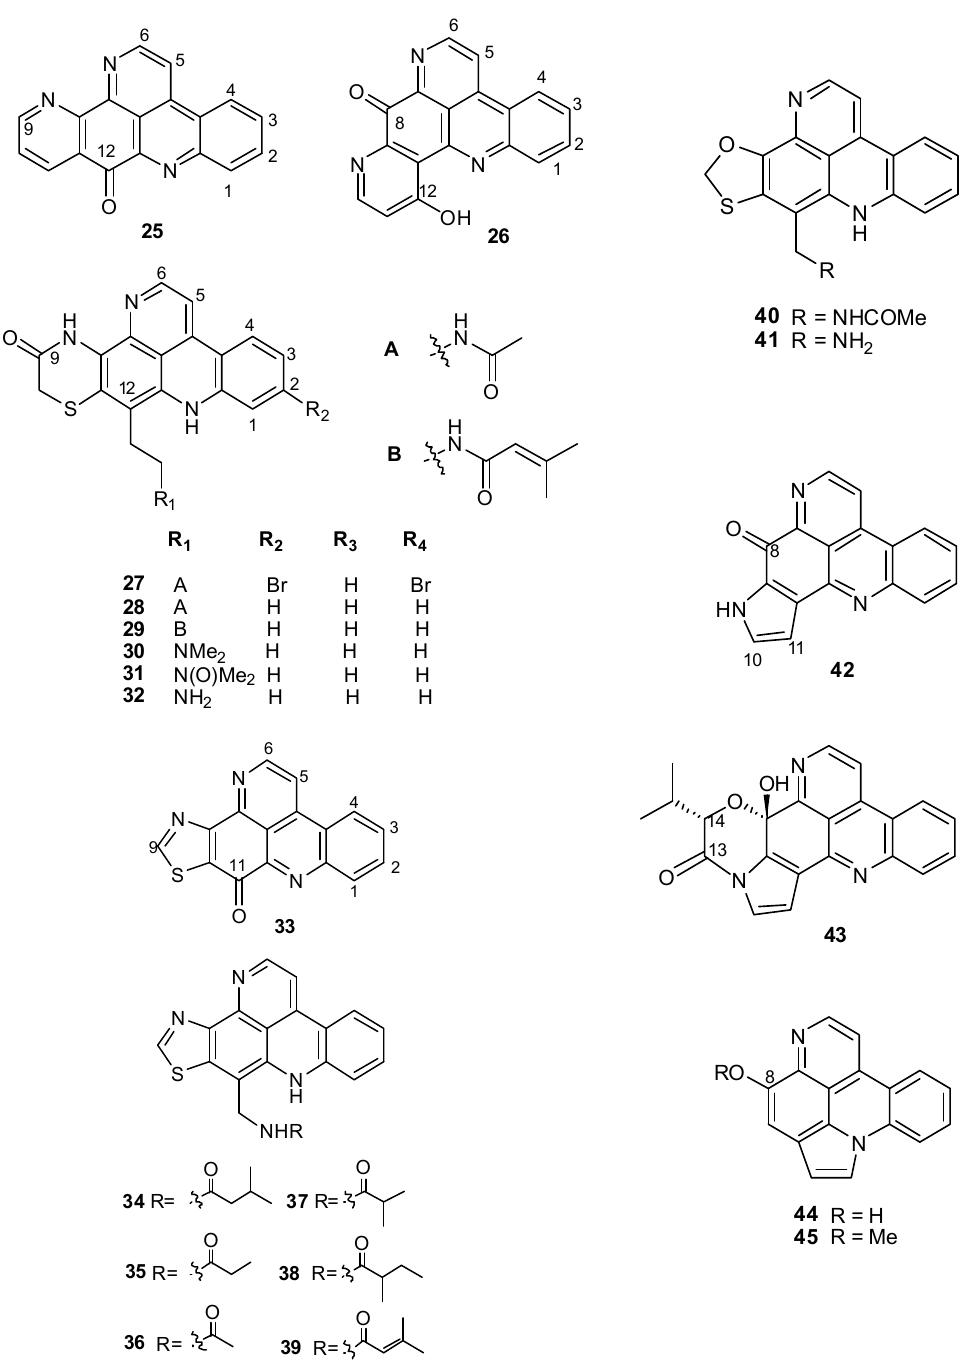
Figure 2. Pentacyclic pyridoacridine alkaloids from